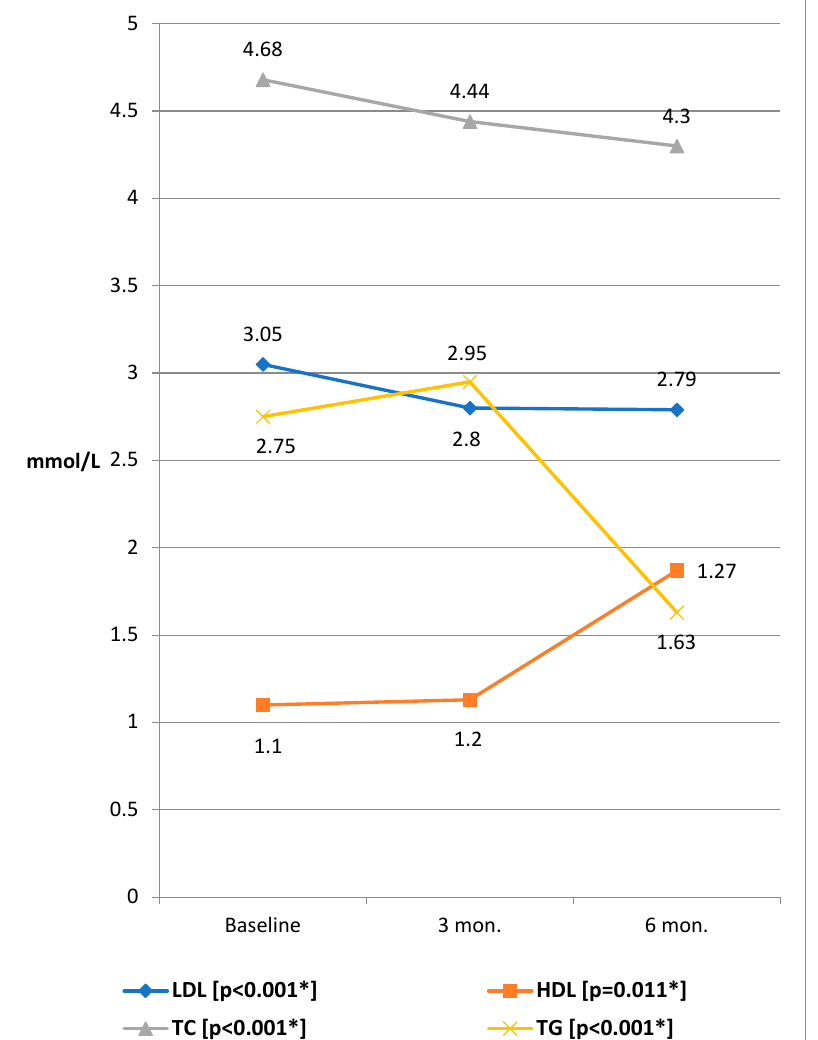
Figure 2. Mean values of lipid profile parameters before and after the educational intervention.